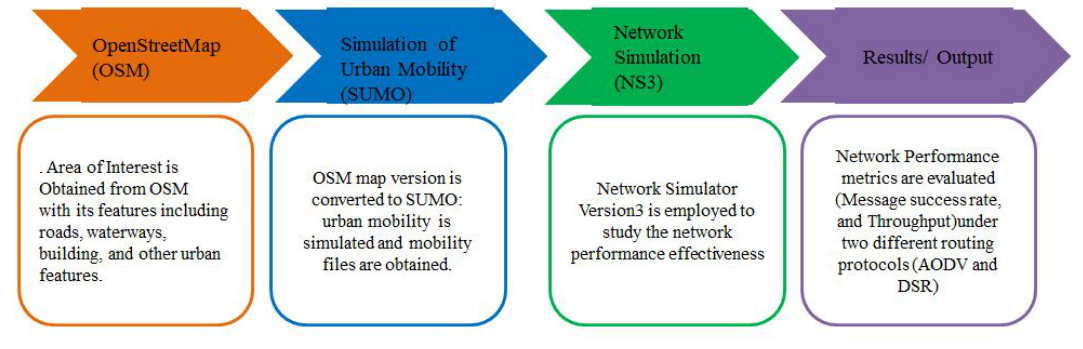
Figure 3. Simulation Design.